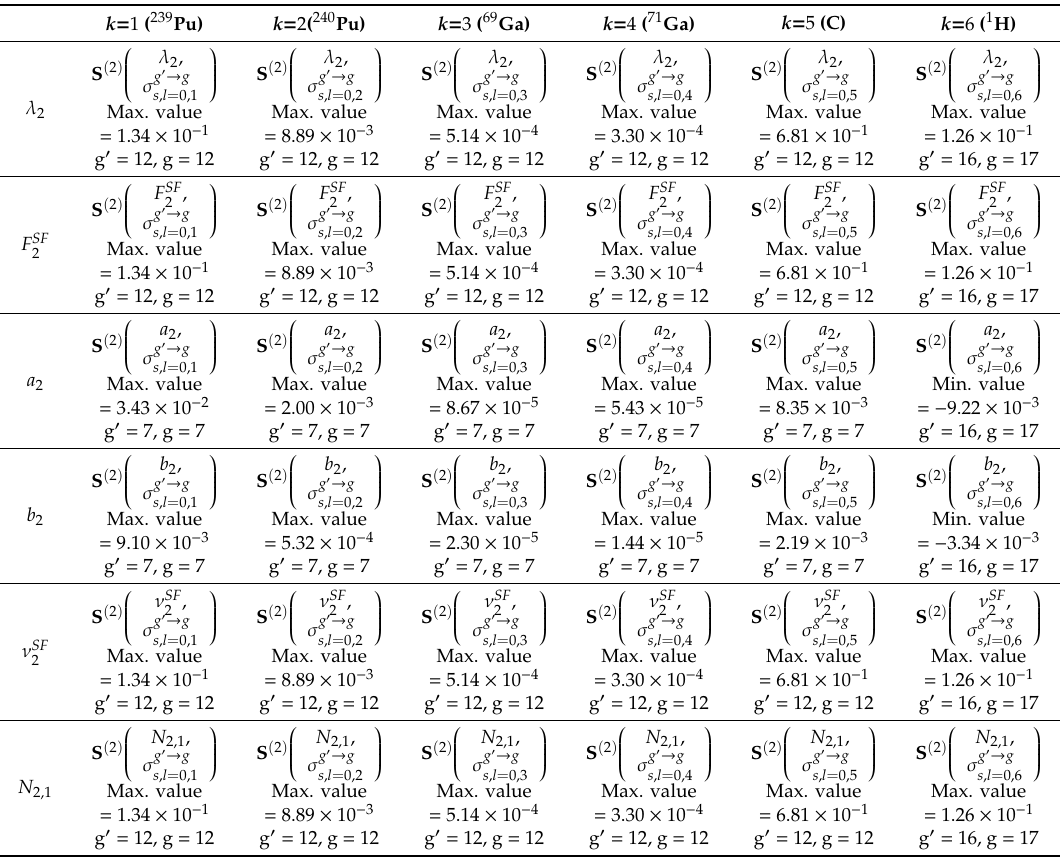
(cid:16) (cid:17) (cid:48) → g q j , σ g , for 2nd-order relative sensitivities of s , l = 0, k